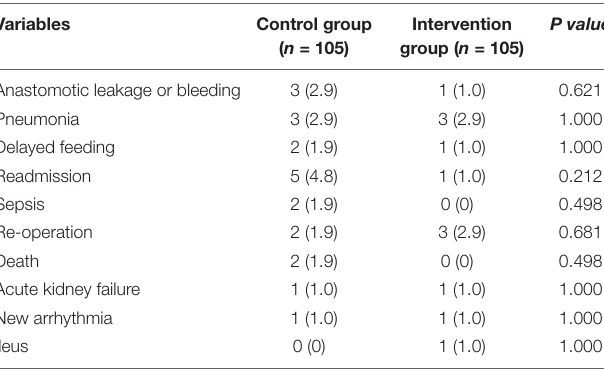
TABLE 3 | Postoperative complications within 30 days analyzed in the intention-to-treat